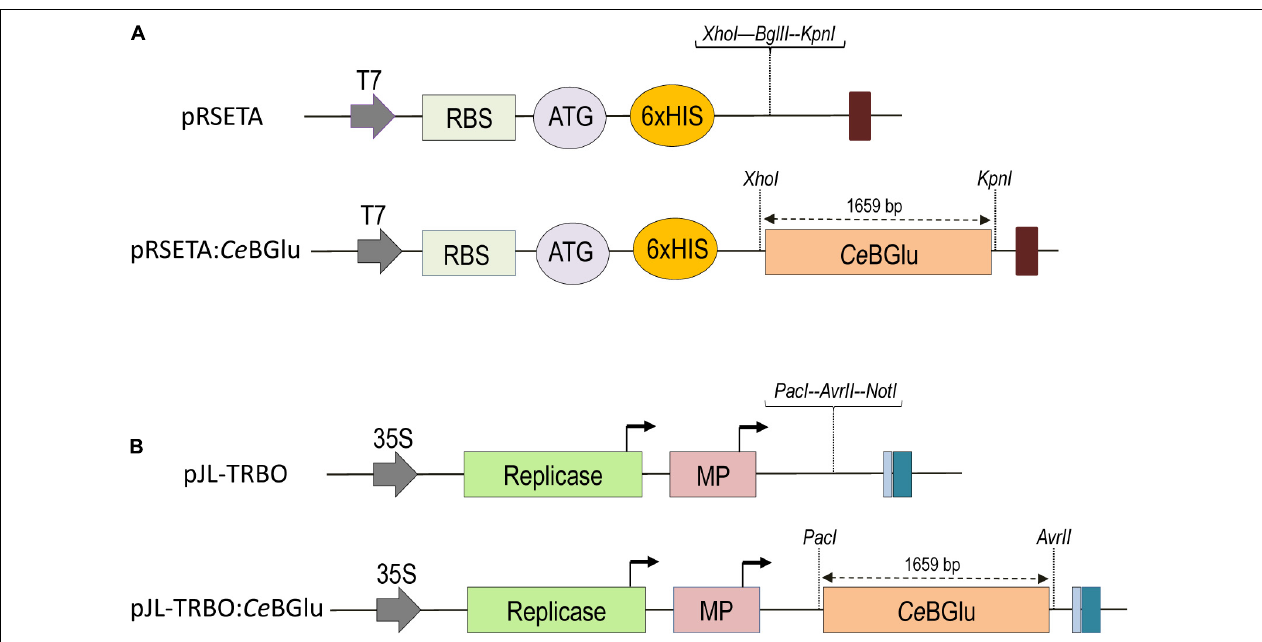
FIGURE 2 | Maps of vectors used in this study, pRSETA for the expression in E.coli (A) and pJL-TRBO for overexpression in C. erythraea (B) . CeBGlu, β -D-glucosidase from C. erythraea , was inserted as a XhoI-KpnI fragment into pRSETA expression vector (A) , or as PacI-AvrII fragment into pJL-TRBO (B) to produce pRSETA:CeBGlu and pJL-TRBO:CeBGlu constructs, respectively. The T-DNA regions of binary plasmids are presented. Block arrow, CaMV duplicated 35S promoter and T7 promoter. Dark blue box, CaMV polyA signal sequence/terminator. Light blue box, Ribozyme. Bent arrows, Subgenomic promoters. ORFs are represented by colored boxes and their identities are labeled in boxes. Replicase, TMV 126K/183K ORF; MP, movement protein; RBS, ribosome binding site; Colored oval boxes present start codon (ATG) and polyhistidine-tag sequence